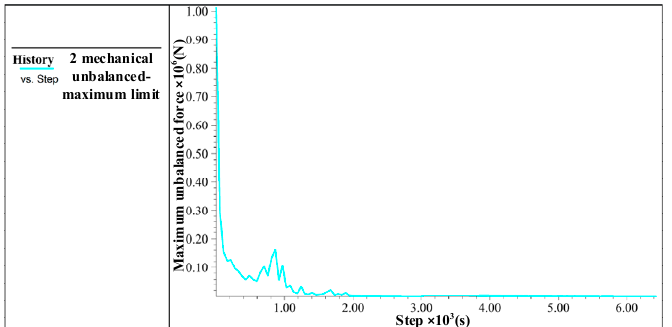
Figure 9. Maximum unbalanced force.